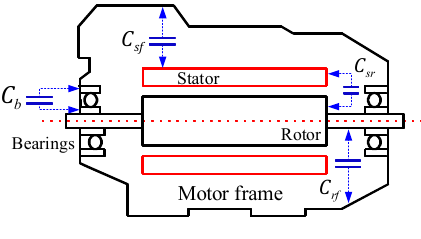
Figure 3. Motor stray capacitances.